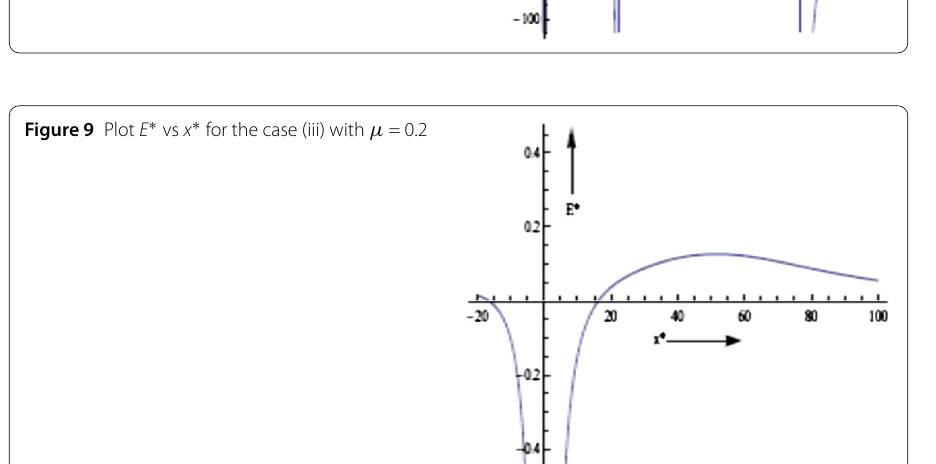
Figure 9 Plot E ∗ vs x ∗ for the case (iii) with μ =